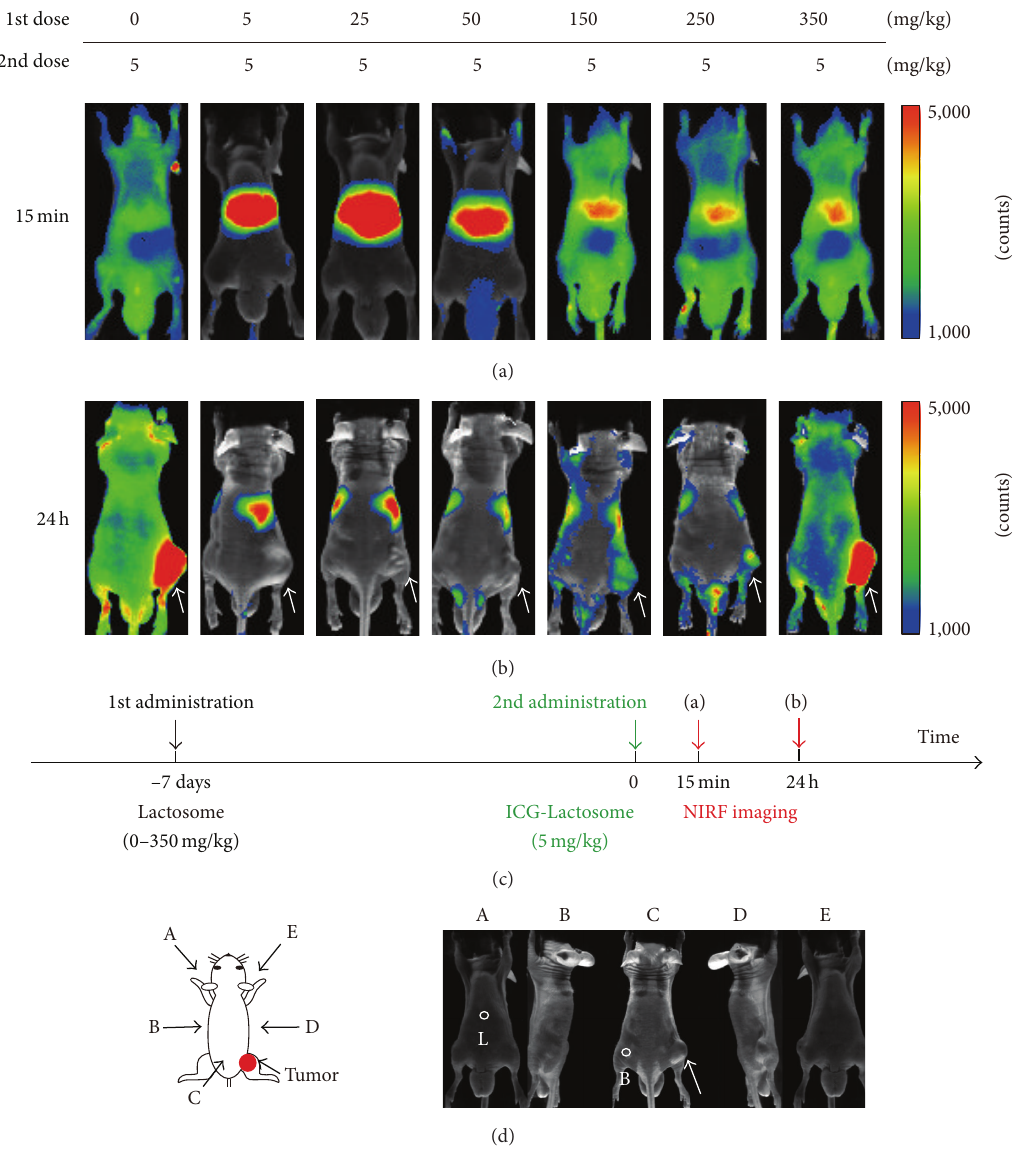
Figure 6: Effect of the first Lactosome dose on the Lactosome ABC phenomenon. NIRF images of mice at (a) 15 min (view from A in Figure 6(d)) and (b) 24 h (view from C in Figure 6(d)) after ICG-Lactosome of 2nd dose. Lactosomes (5, 25, and 50 mg/kg/100 𝜇 L and 150, 250, and 350 mg/kg/200 𝜇 L) were injected into the mice 7 days before the ICG-Lactosome administration. SUIT-2/pEF/luc cells were transplanted at the right femoral region of mice, in which tumor sites are indicated by white arrows. The fluorescein signal ranges were set to be the same for all the images from max count 5000 to min count 1000. (c) Time schedule for the NIRF imaging. Black and green arrows indicate the injection time points of Lactosome and ICG-Lactosome, respectively. NIRF imaging was performed at red arrows. (d) NIRF images were taken using Shimadzu Clairvivo OPT, which can take five images from different directions (A–E) with one time shot. The white circles indicate